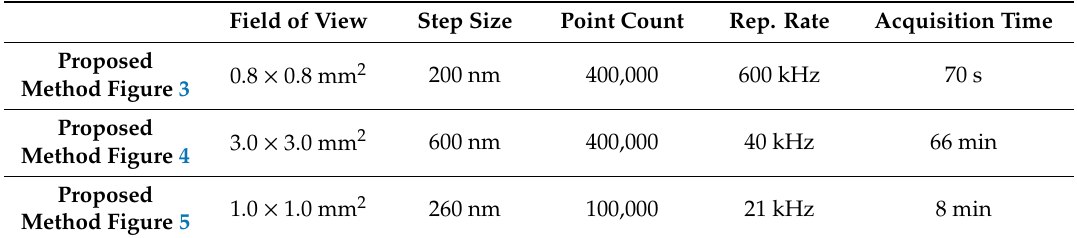
Table 1. Summary of results of the proposed